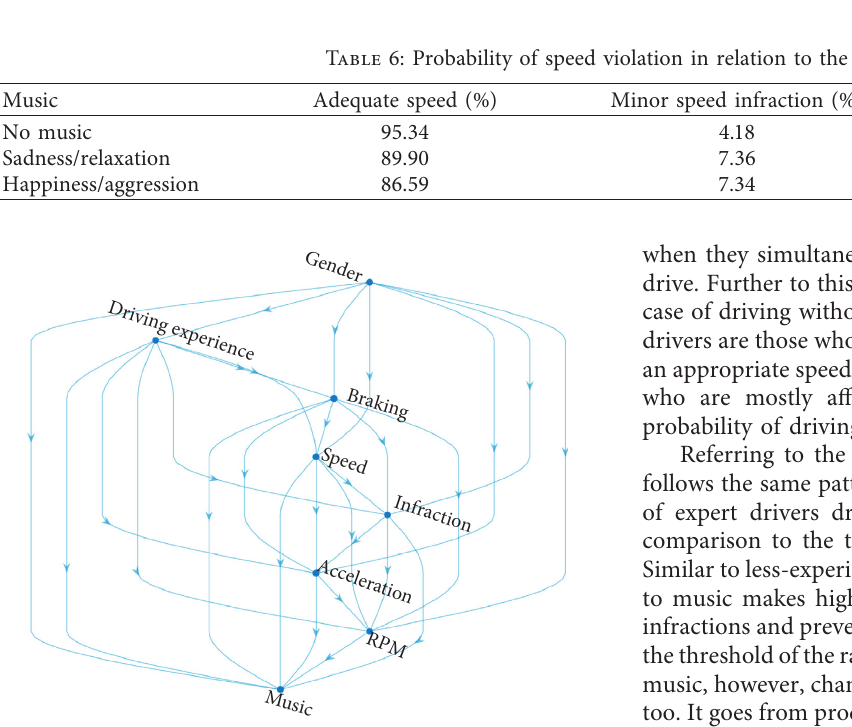
Figure 2: Bayesian network